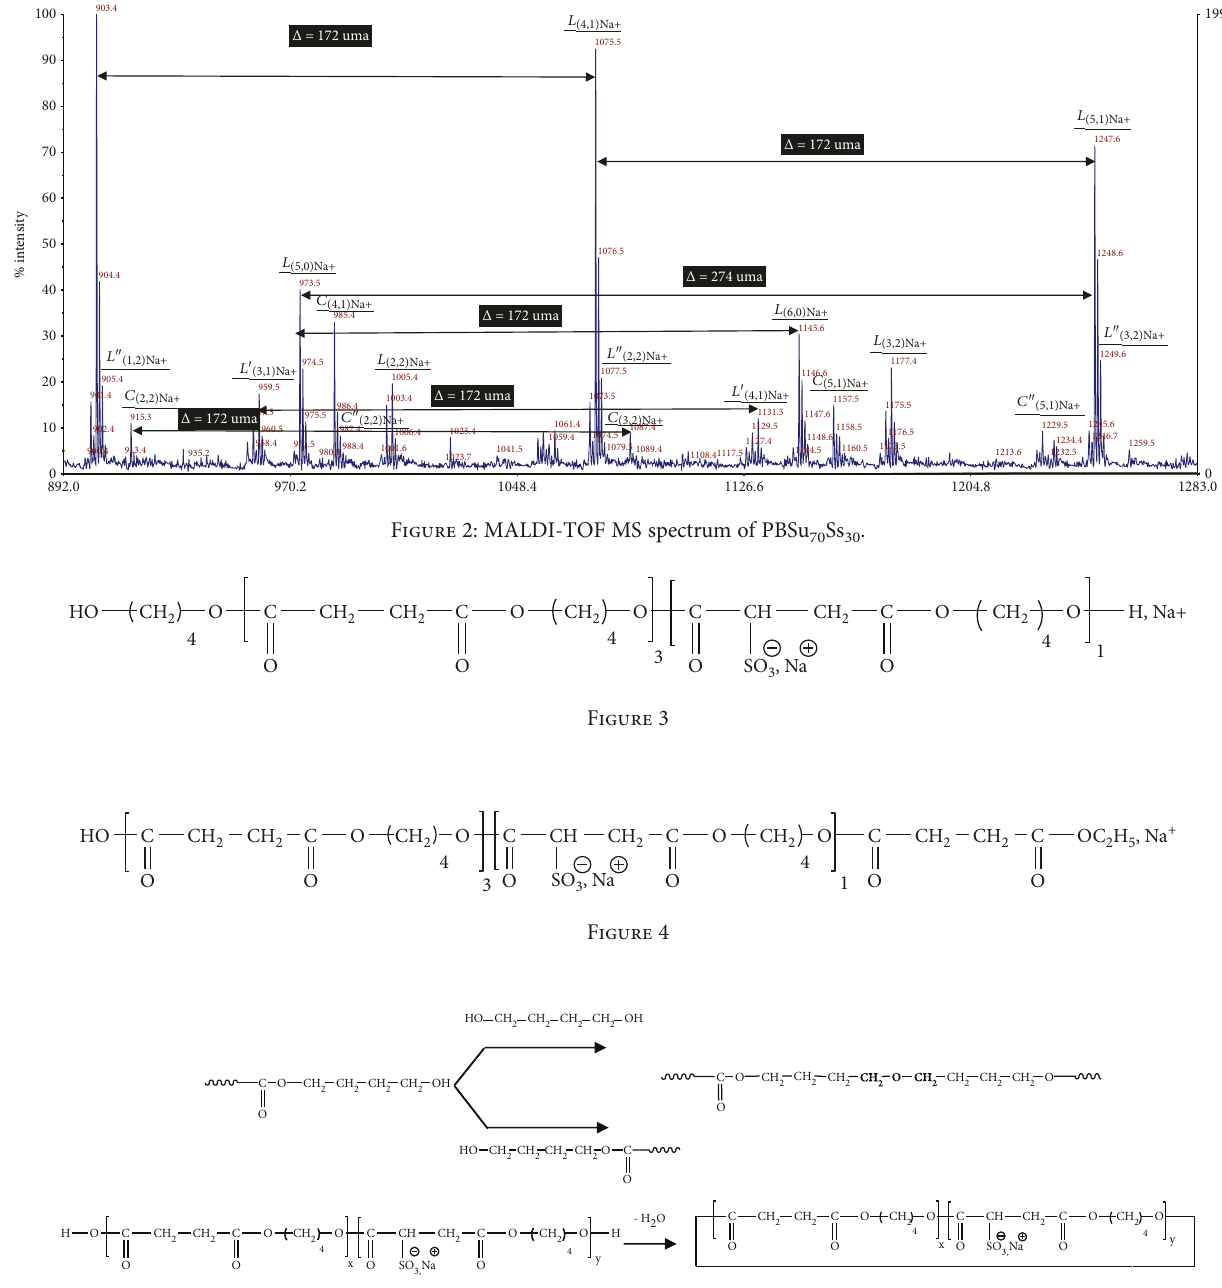
Scheme 2: Possible side reactions involved in PBSu